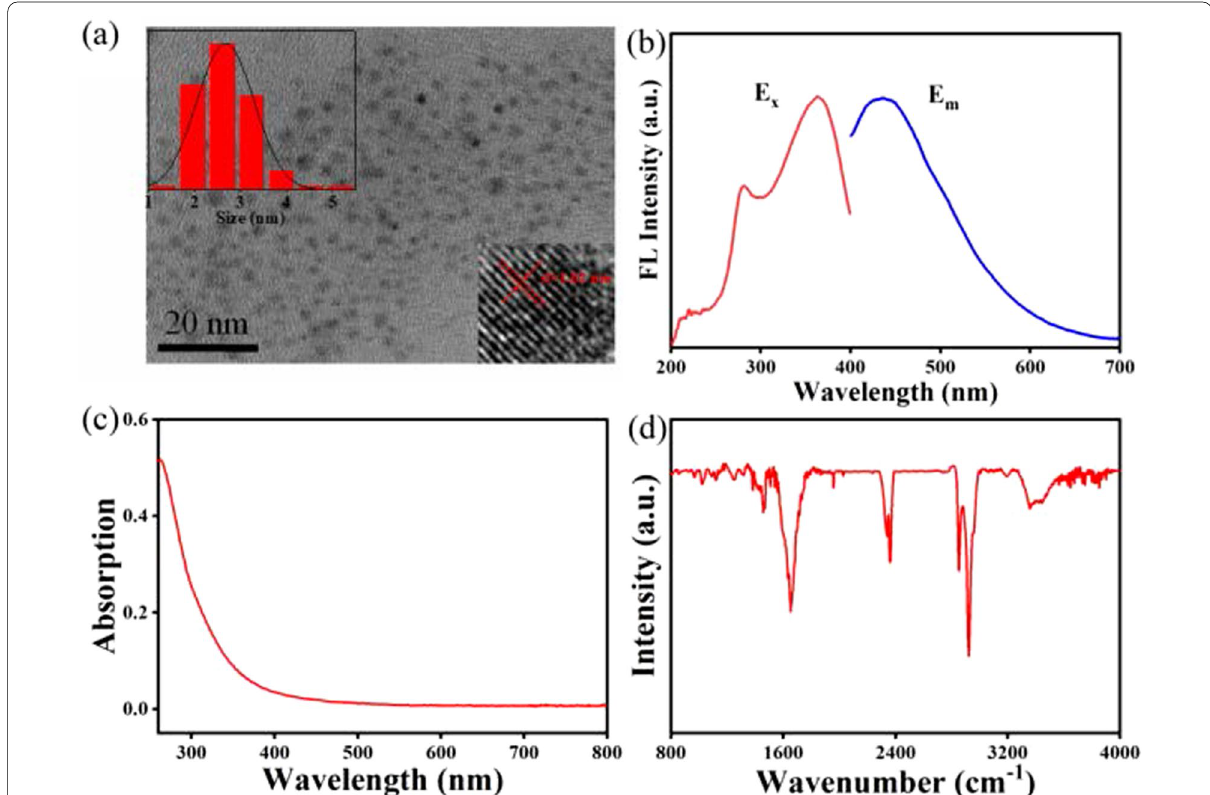
Fig. 2 a TEM image of the synthesized MQDs with quasi-normal distribution of particle’s size image and the lattice spacing in the high-resolution image (left inset and low right inset); b fluorescence emission spectra of the prepared MQDs; c UV–Vis absorption spectrum; and d FTIR spectrum of